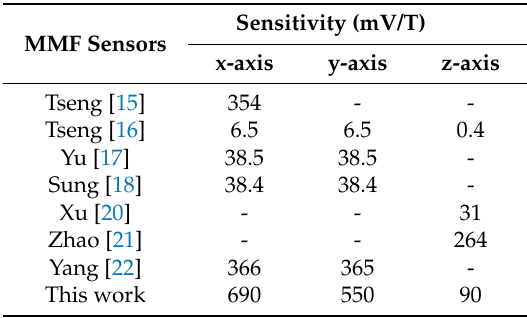
Table 1. Sensitivity of various MMF